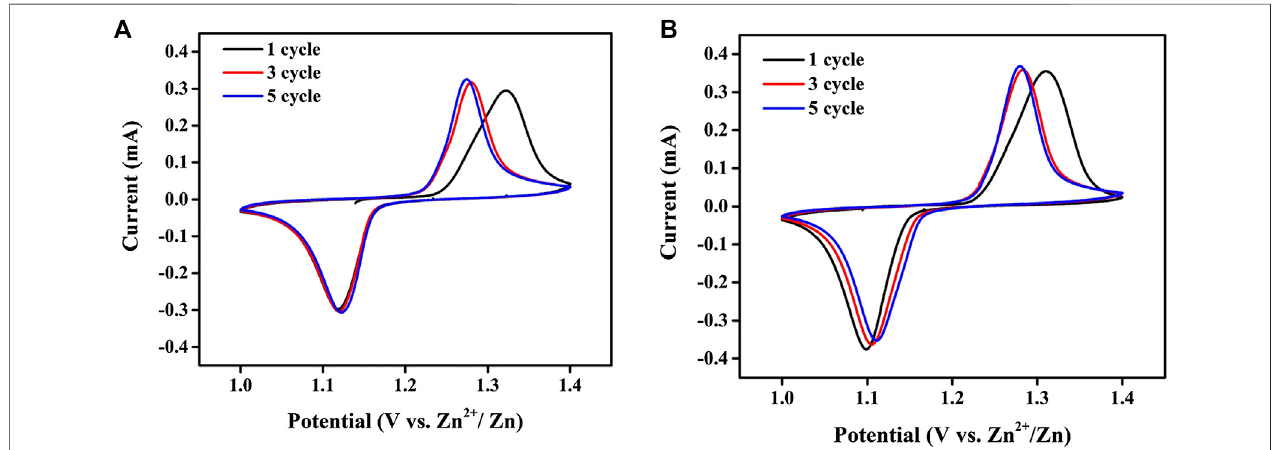
FIGURE 1 | CV pro fi les of Zn/LiFePO 4 cells (A) without and (B) with 0.1 M TPAH in the potential window of 1.0 – 1.4 V at 0.1 mV s − 1